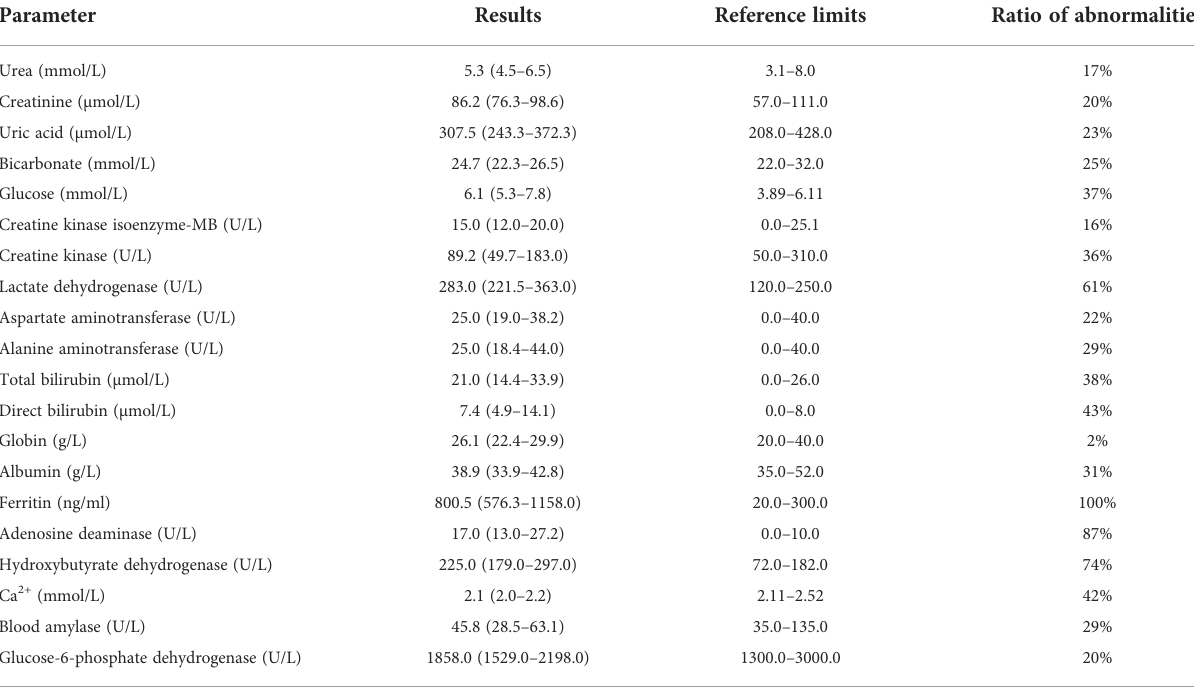
TABLE 2 The biochemical results of patients with imported